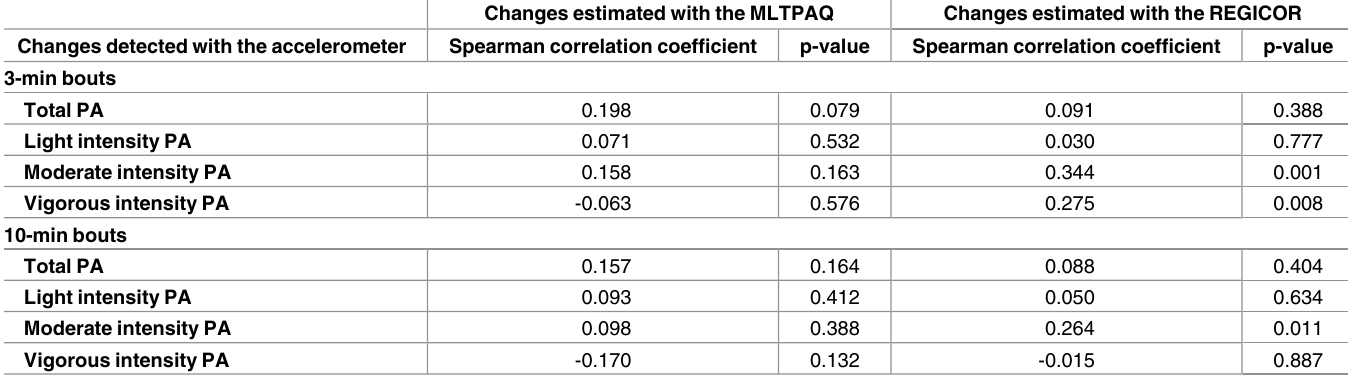
Table 6. Sensitivity to detect changes in physical activity of the Minnesota Leisure Time Physical Activity Questionnaire and the REGICOR ques- tionnaire, assessedby the Spearmancorrelation coefficient between changes estimated by the questionnaires and changes detected by the